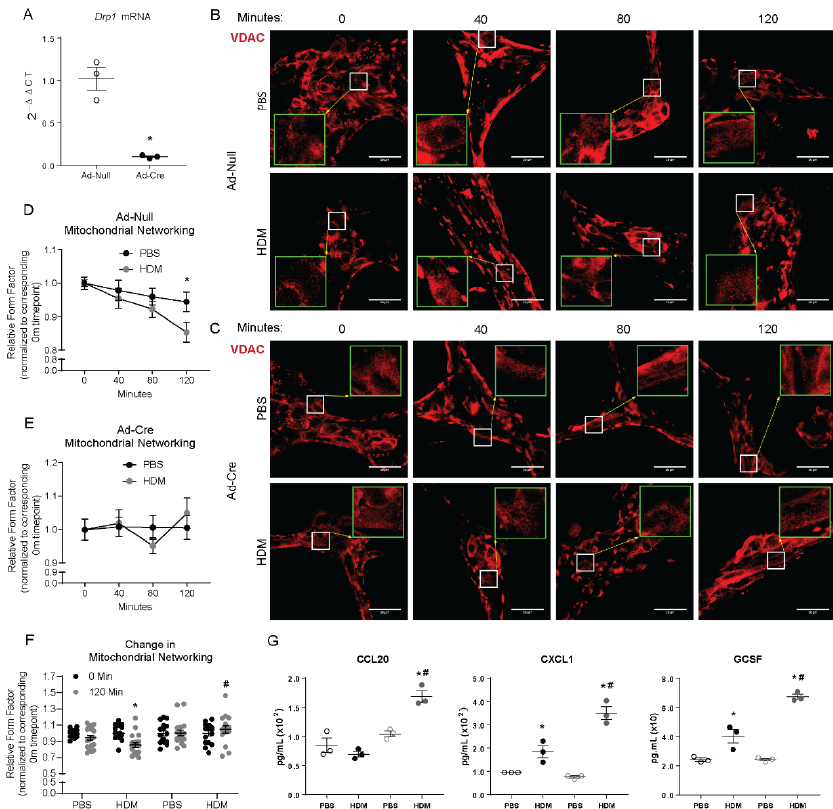
Figure 2. Drp1 deletion impairs mitochondrial fission and enhances the mouse epithelial pro-inflammatory response to HDM. ( A ) RT-qPCR of Drp1 following Cre-induced deletion in cultured MTECs, n = 3 per group; ( B ) Representative images of immunofluorescence of VDAC in fixed MTECs treated with Ad-Null with insets at 3 × magnification in green; ( C ) Representative images of immunofluorescence of VDAC in fixed MTECs treated with Ad-Cre with insets at 3 × magnification in green; ( D ) Quantification of mitochondrial networking based on VDAC immunofluorescence, form factor calculation with Null n = 19–21 images per group; ( E ) Quantification of mitochondrial networking based on VDAC immunofluorescence, form factor calculation with Cre n = 14–18 images per group at 60 × magnification; ( F ) Overall change in mitochondrial networking, each data point represents 1 image; ( G ) ELISAs on supernatants from MTECs, n = 3 per group; ( A ) * p < 0.05 vs. Ad-Null group; ( B , C ) Scale bars are 50 µ m. ( D , E ) * p < 0.05 PBS vs. HDM; ( F ) * p < 0.05 vs. corresponding 0 Min group, # p < 0.05 vs. Ad-Null HDM 120 Min group; ( G ) * p < 0.05 vs. corresponding PBS group, # p < 0.05 vs. Ad-null HDM group. Error bars represent mean ±